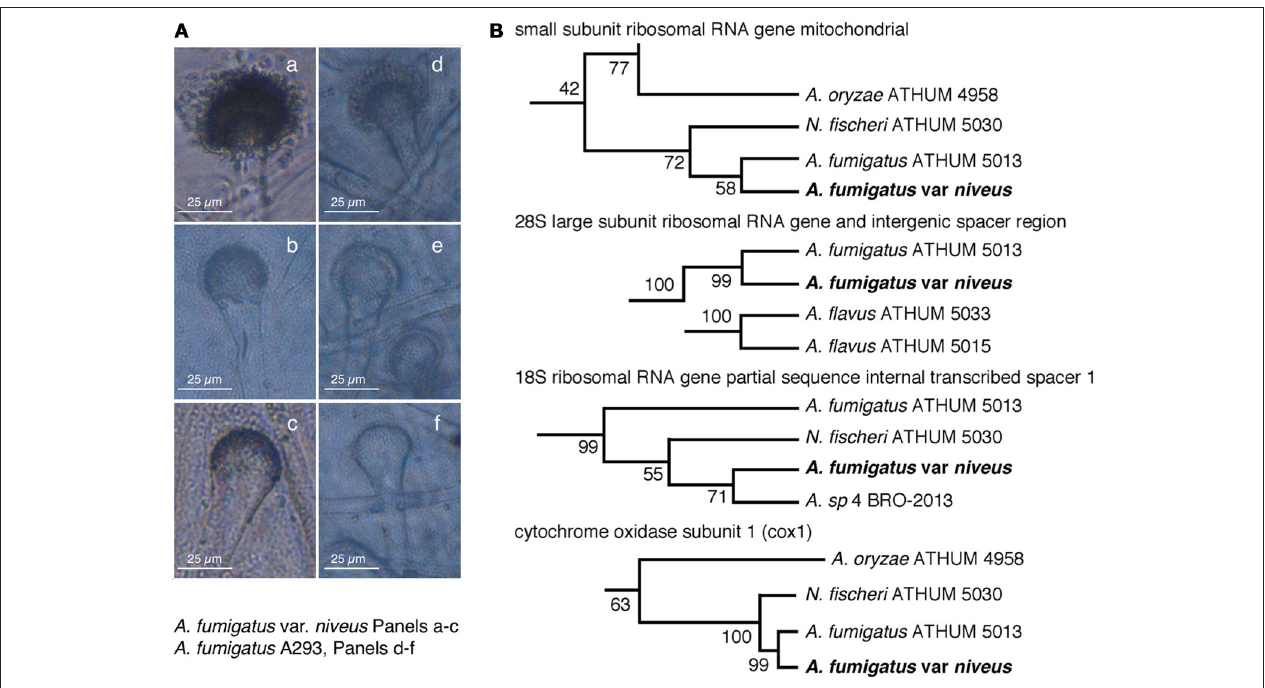
FIGURE 2 | Taxonomic identification of an albino Aspergillus as Aspergillus fumigatus var. niveus (AFUMN). (A) Morphotaxonomy of aspergilli conidiophore vesicle shape. (a – c) and (d – f) show the albino Aspergillus and Aspergillus fumigatus Af293 conidiophore vesicles, respectively. (B) Ribosomal RNA neighbor-joining phylotaxonomy of small 18S and large 28S subunit internal spacer sequences cluster the albino Aspergillus isolate with Aspergillus fumigatus ATHUM 5013 and Neosartoria fisheri ATHUM 5030. Only a small section of a complete phylogenetic tree is shown. Full trees with bootstrap values can be found in Figure S1 .